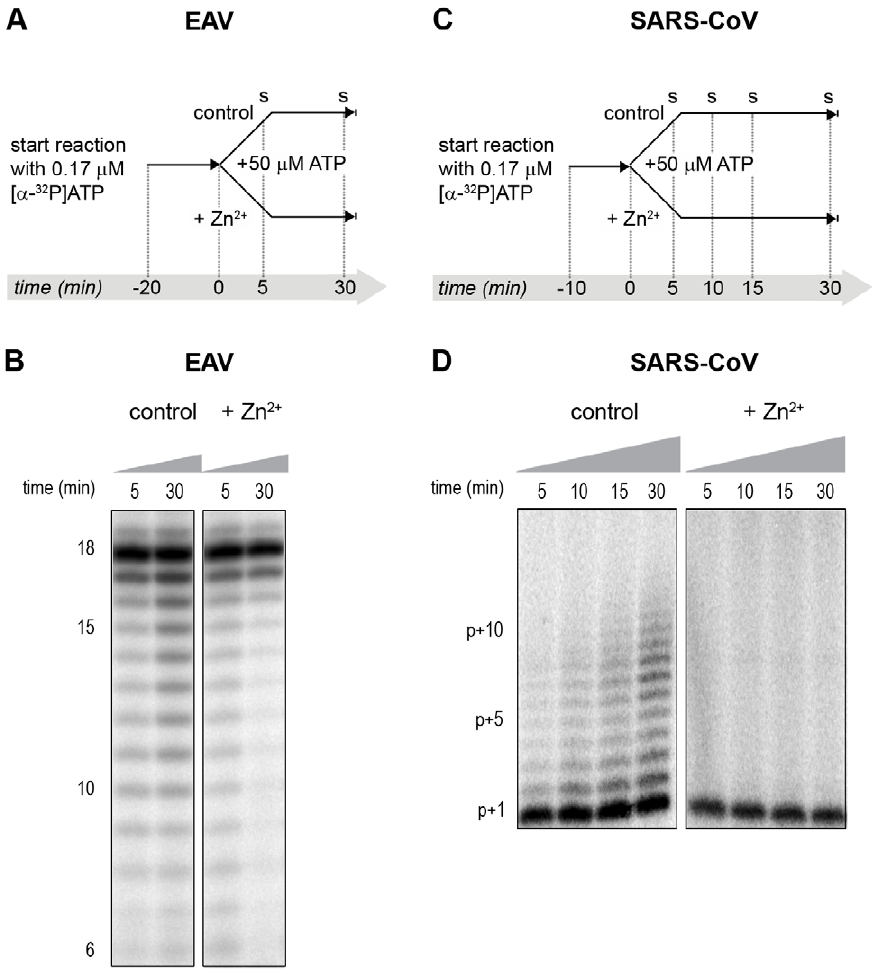
Figure 7. The effect of Zn 2 + on initiation and elongation activity of purified EAV and SARS-CoV RdRps. ( A ) An EAV RdRp reaction was initiated in the presence of [ a - 32 P]ATP under conditions that do not allow elongation, i.e. , low ATP concentration. After 20 min, the reaction was split into two equal volumes, and Zn 2 + was added to one of the tubes. A chase with 50 m M unlabeled ATP, which allows elongation, was performed on both reactions and samples were taken after 5 and 30 min. ( B ) EAV RdRp reaction products that accumulated in the presence and absence of Zn 2 + (indicated above the lanes) after a 5- and 30-min chase with unlabeled ATP. The length of the reaction products in nt is indicated next to the gel. ( C ) A SARS-CoV RdRp reaction was initiated in the presence of 0.17 m M [ a - 32 P]ATP, which limits elongation. After 10 min, the reaction was split into two equal volumes, and Zn 2 + was added to one of the tubes. A chase with 50 m M unlabeled ATP was performed on both reactions and samples were taken after 5, 10, 15, and 30 min. ( D ) SARS-CoV RdRp reaction products formed at the chase times indicated above the lanes in the presence and absence of Zn 2 + . The length of the reaction products in nt is indicated next to the gel (p is the primer length).